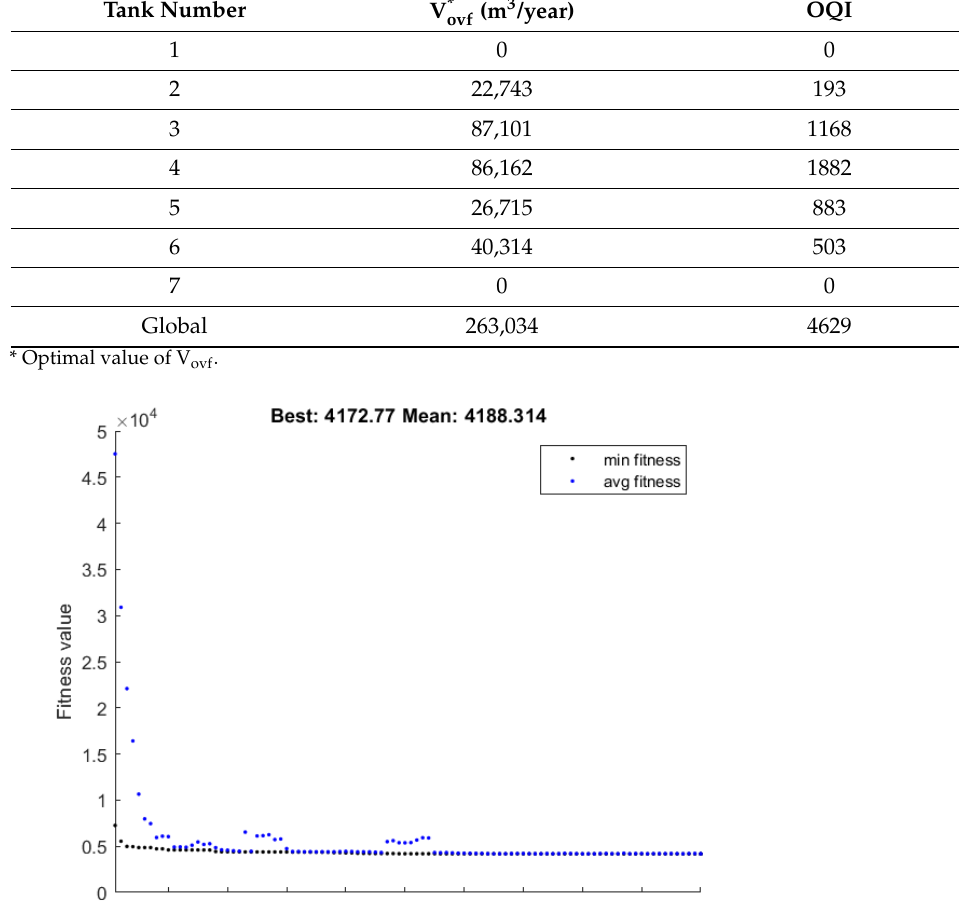
The simulation results are presented in Table 14. Table 14. Simulation results when the overflow quality index is minimized (strategy #4). Tank Number